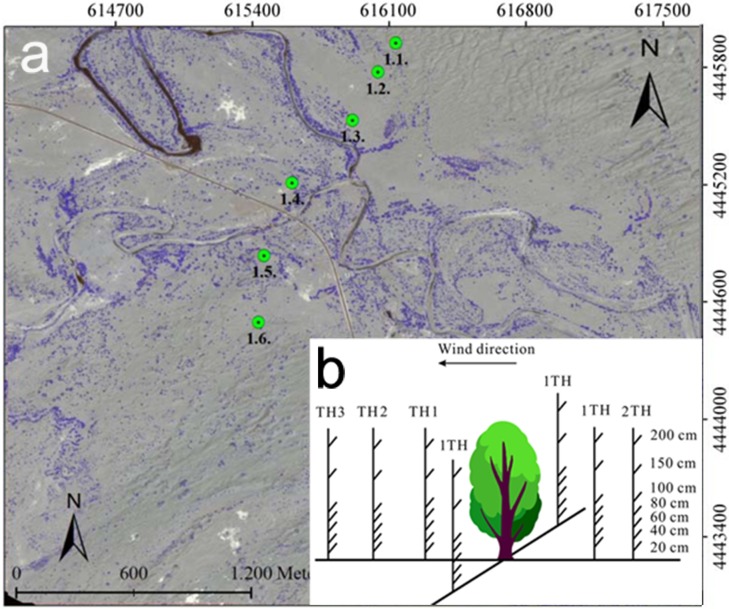
(a) Sediment trap installing points at two transect in the experimental area (Arghan) and (b) Apparatus to observe wind velocity around a single plant.